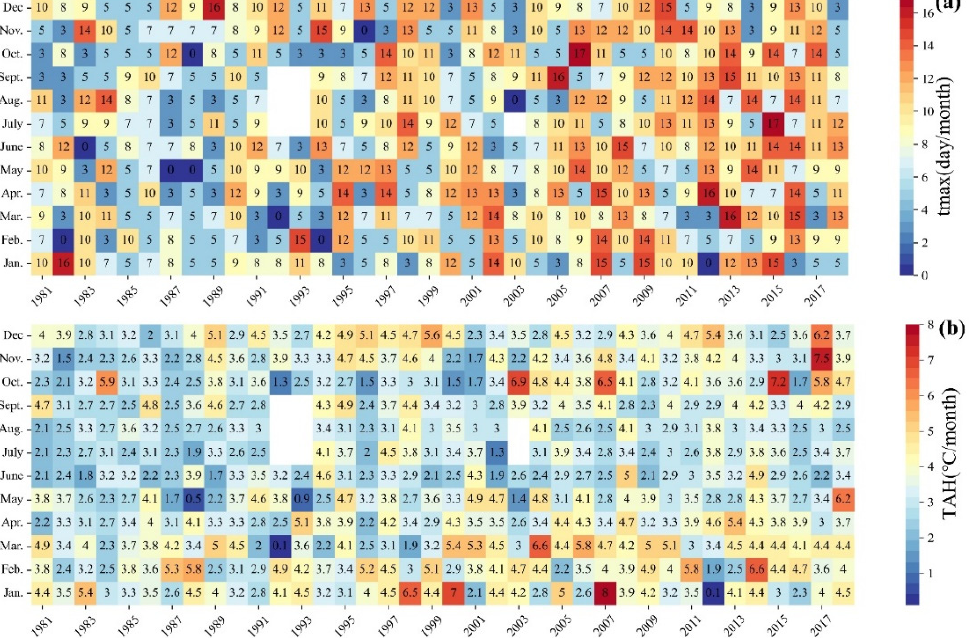
Figure 3. Monthly means in the panel axes. ( a ) Maximum duration tmax of CDHWs using a monthly scale, and ( b ) the average temperature TAH anomalies of CDHWs using a monthly scale. (The grid value is the maximum value for the corresponding month.).